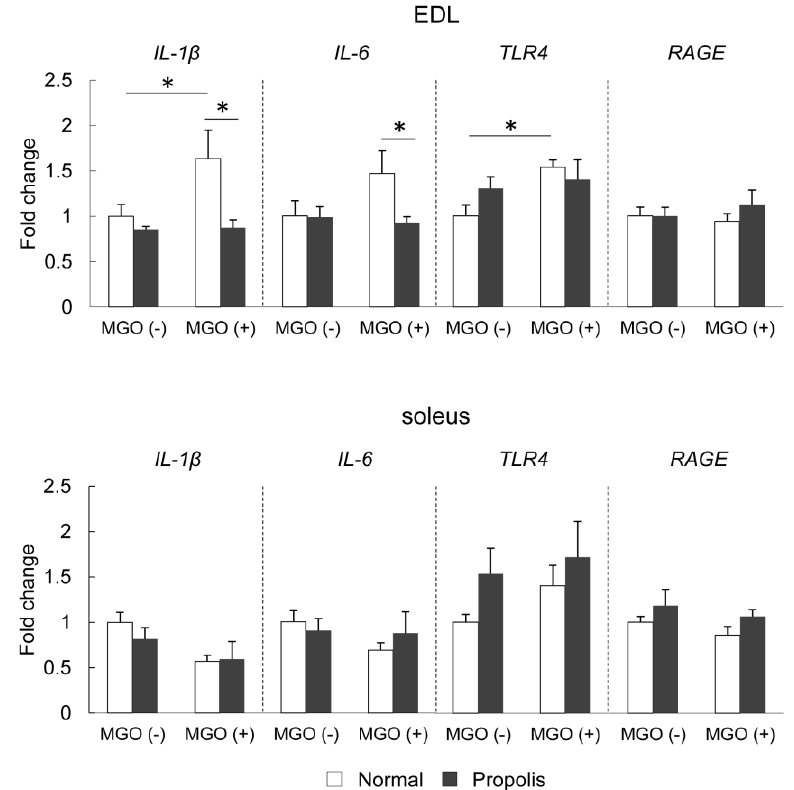
Figure 4. mRNA expression of interleukin (IL)-1 β , IL-6, toll-like receptor 4 (TLR4), and receptor for AGEs (RAGE) in skeletal muscles. The EDL and soleus muscles were dissected from mice treated with or without propolis (0.1%)-containing diet or MGO (0.1%)-containing drinking water for 20 weeks. Data of IL-1 β in the EDL muscle were log-transformed for normal distribution before analysis of variance (ANOVA). Values are means ± SE; n = 3–6 / group. * p < 0.05 between the groups.